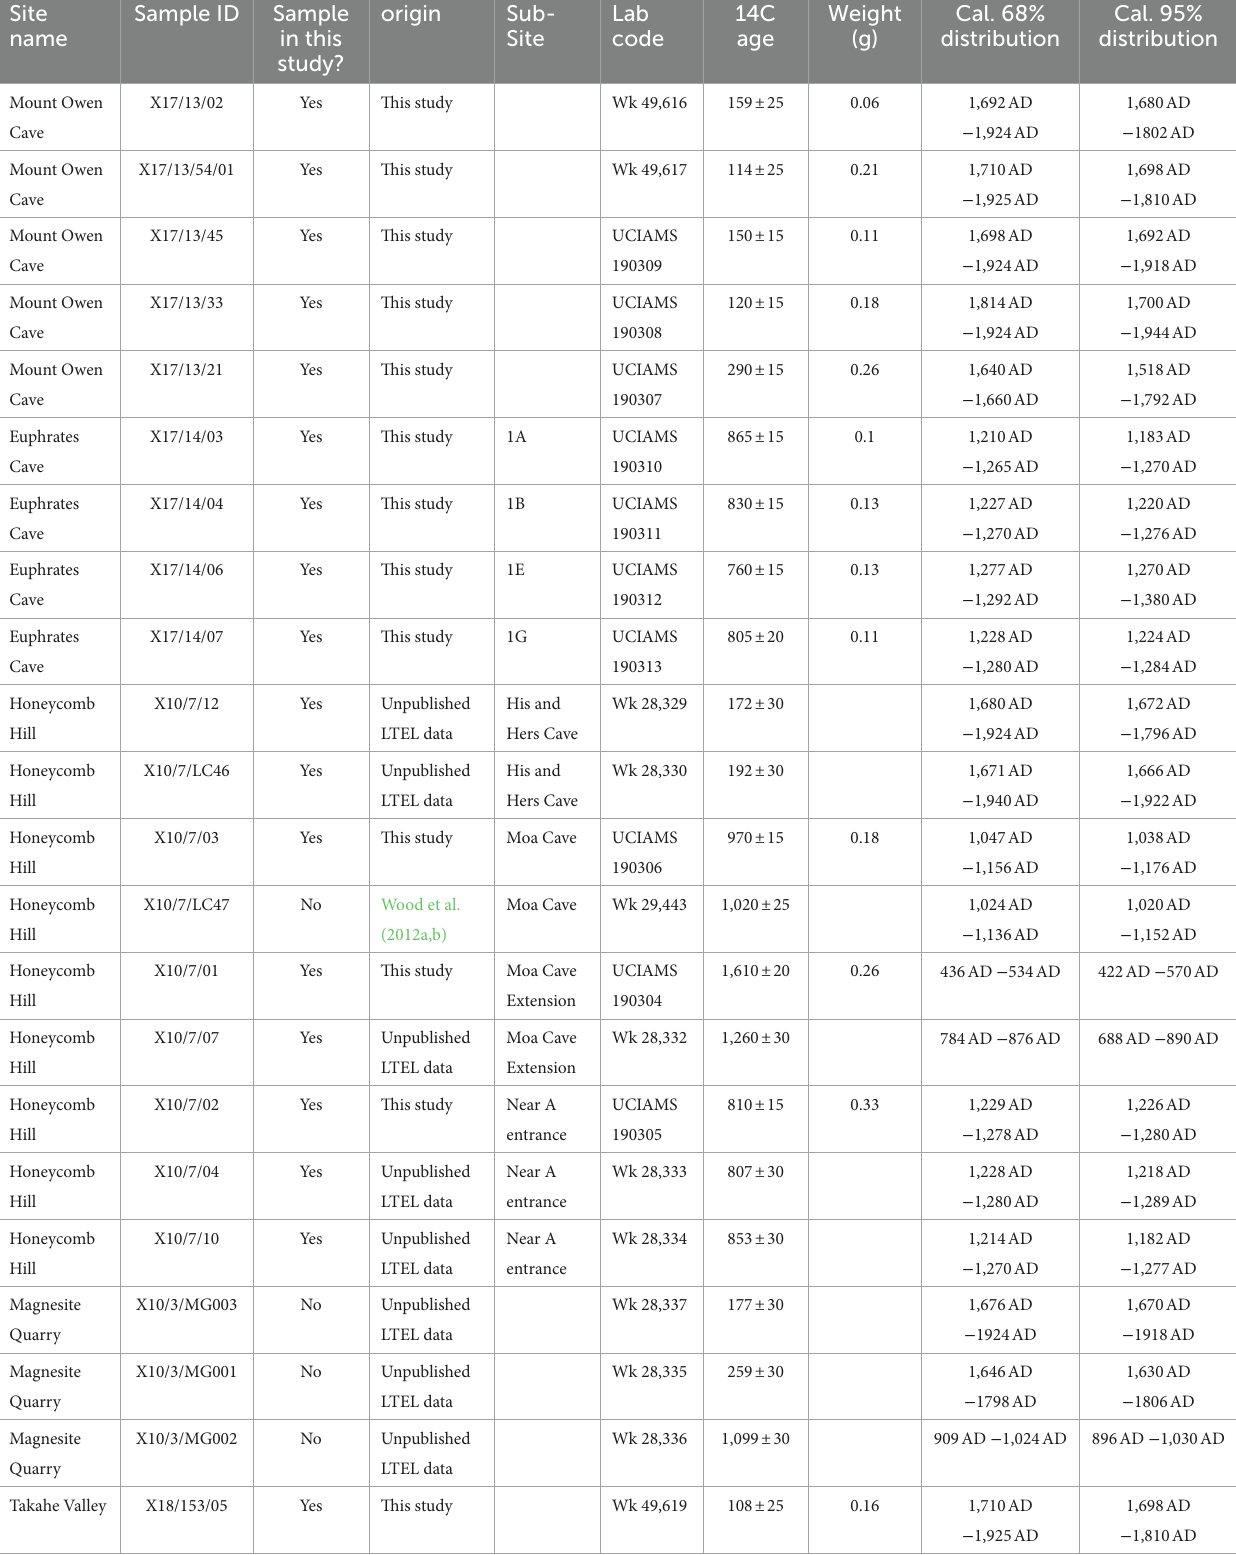
TABLE 2 List of 14 C dates of kākāpō coprolites obtained by the Long-Term Ecology Lab (LTEL), including published and unpublished dates, as well as dates obtained specifically for this